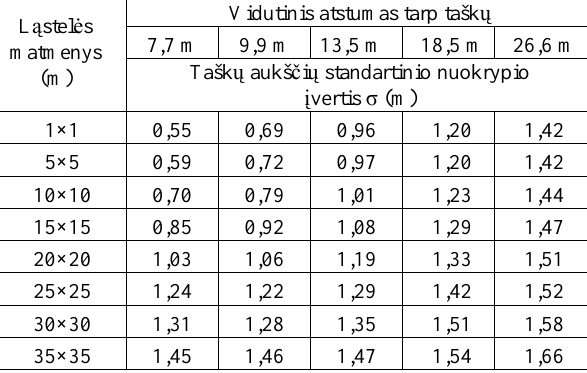
Table 1. Accuracy analysis of DEM created by kriging method Vidutinis atstumas tarp tašk ų